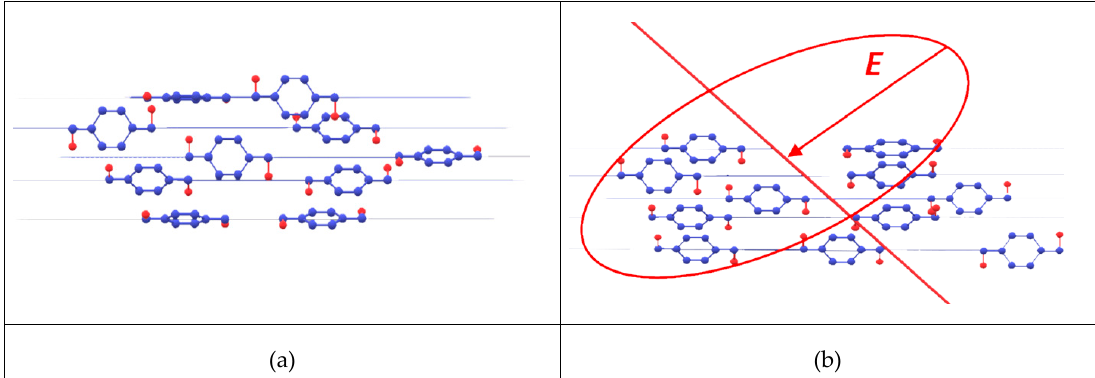
Figure 8. Schematic representation of the orientation of benzene-carboxyl units of the amorphous phase of the PET film: ( a ) pristine; ( b ) in the residual electric field of the latent track.